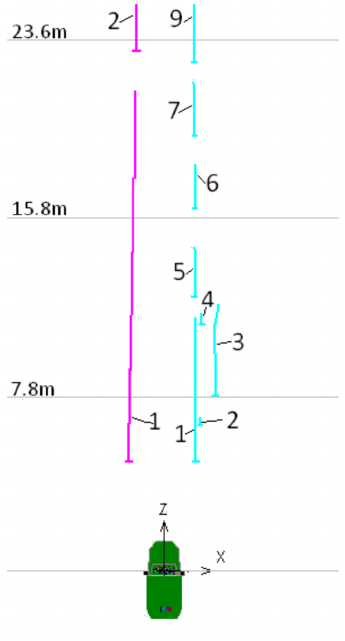
Figure 11. Inverse perspective transformation corresponding to Figure 10 up to 25